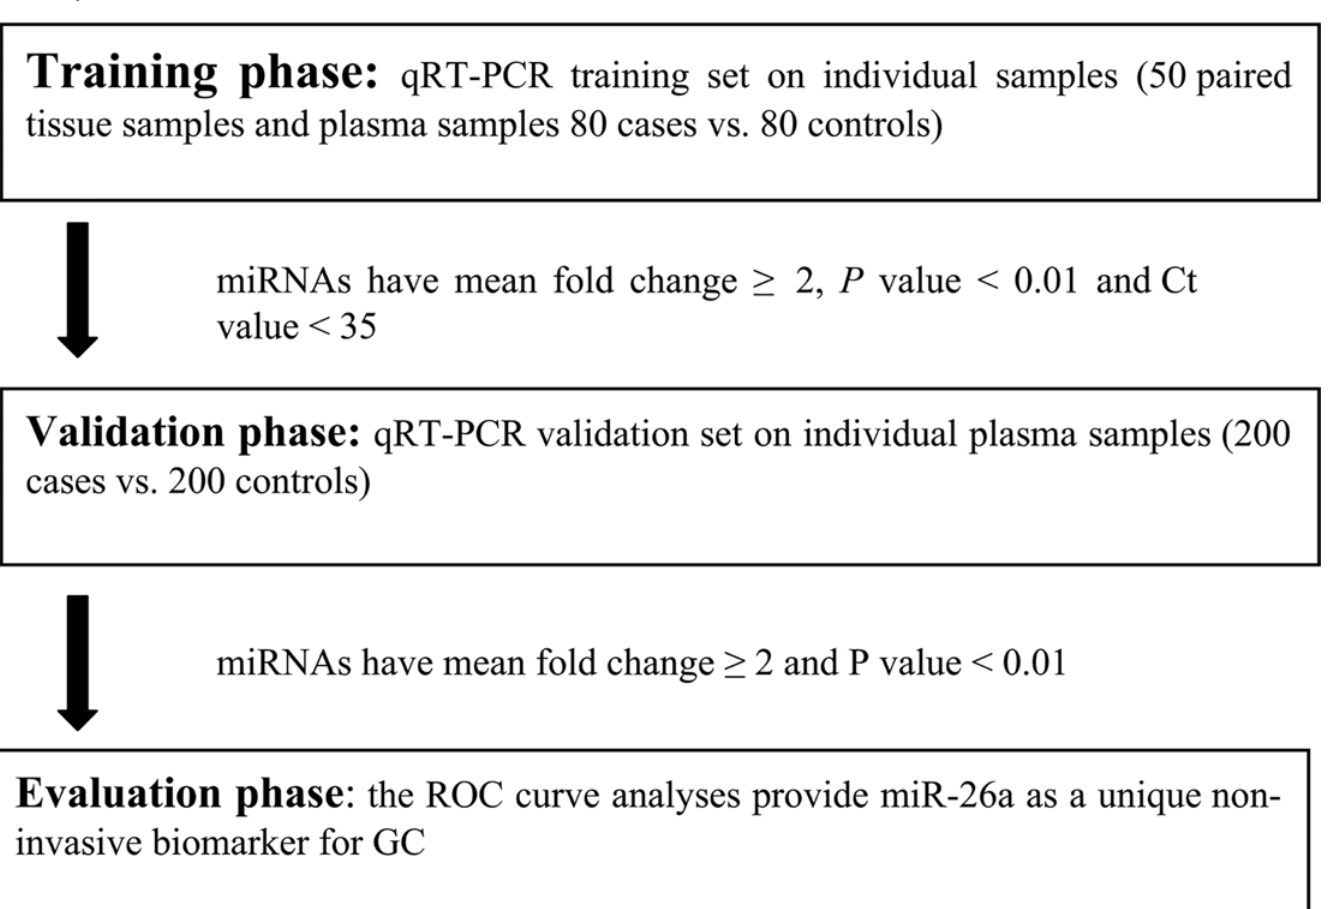
Fig 1. A flow chart of the experimental